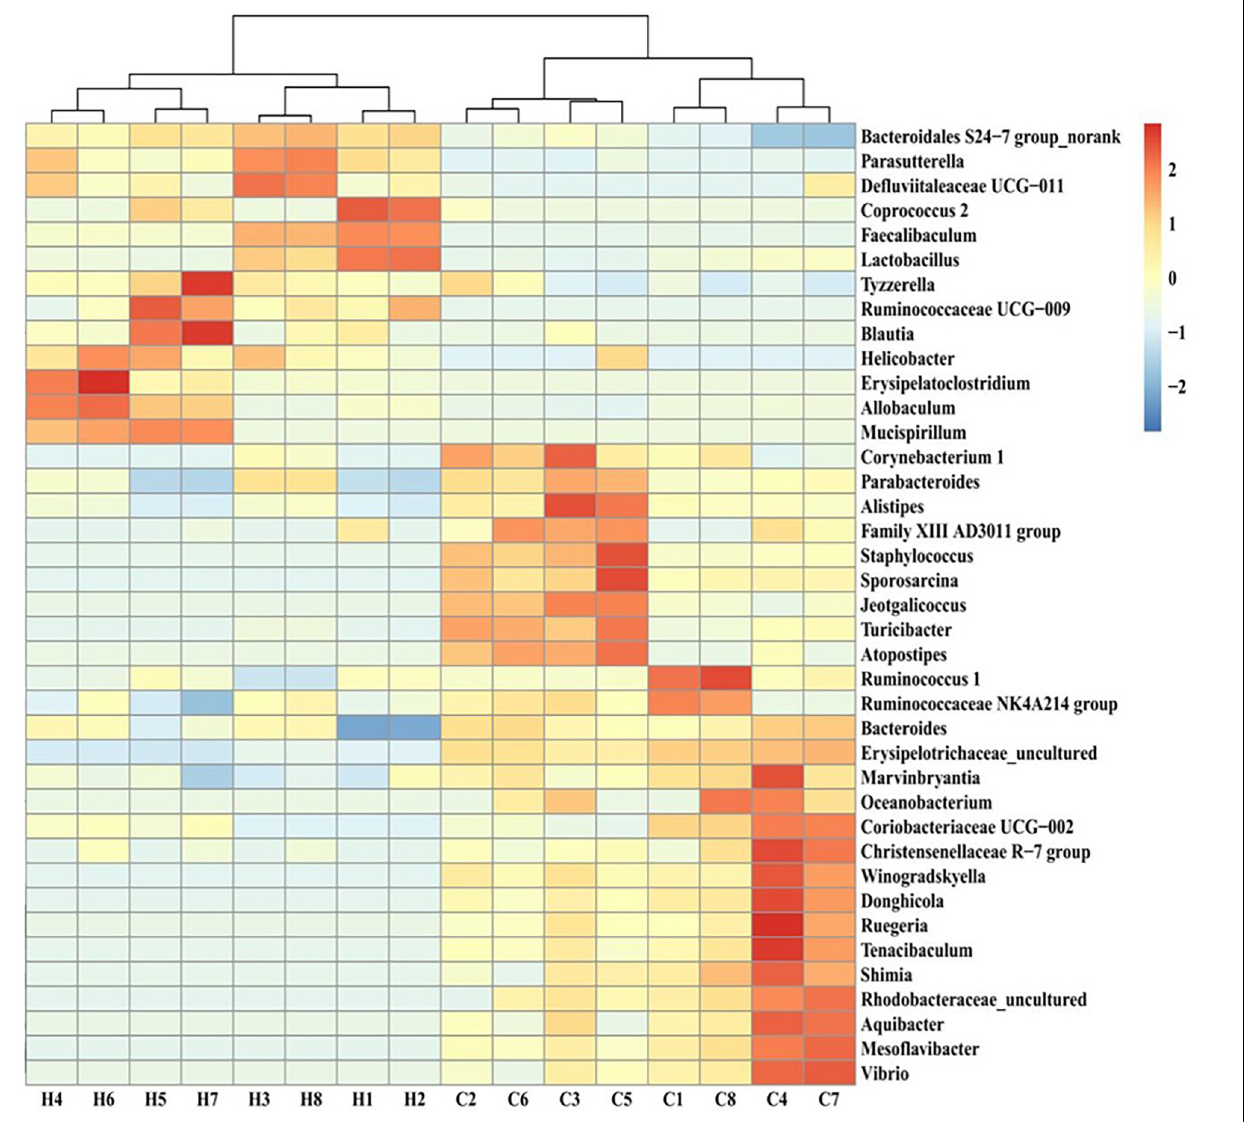
FIGURE 8 | Heat map of the intestinal flora of different genera in control and HFCS-fed mice. C1–C8, individual control mice; H1–H8, individual HFCS-fed